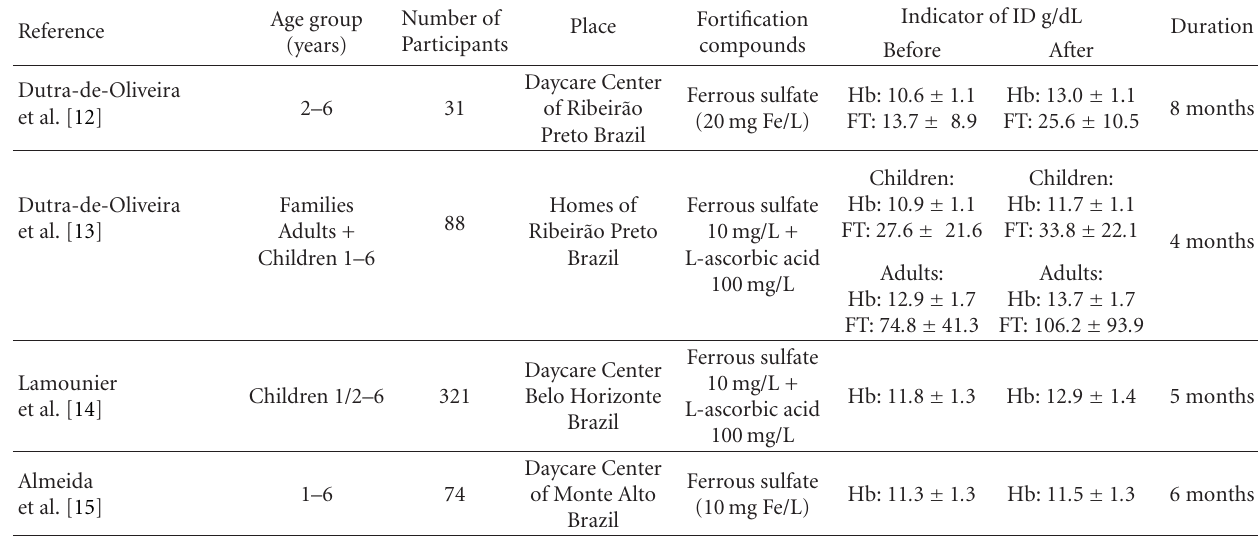
Table 1: Clinical work carried out in preschool children with iron fortified drink water in